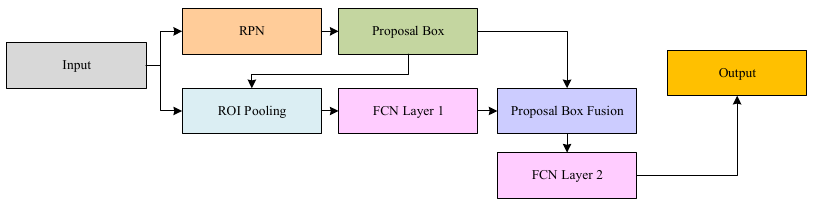
Figure 10. Proposal boxes